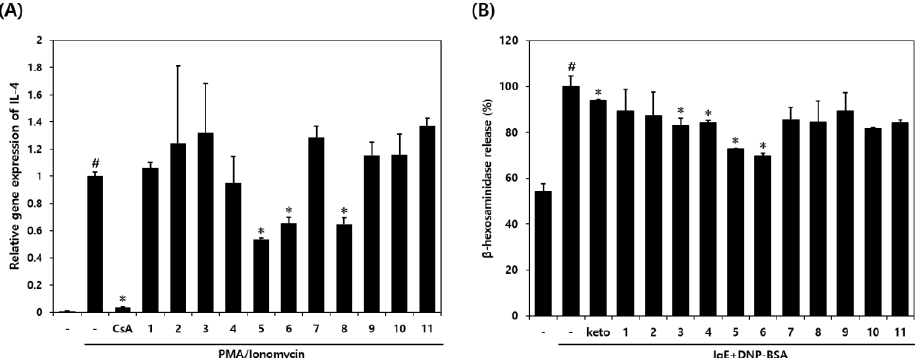
Figure 5. Anti-inflammatory and anti-allergic effects of compounds isolated from DCE on IL-4 levels and β -hexosaminidase release. ( A ) Expressions of IL-4. ( B ) β -hexosaminidase release. CsA: PI plus cyclosporin A-treated group, keto: IgE + DNP-BSA plus ketotifen-treated group. Data values are presented as the means ± SDs. # p < 0.05 vs. vehicle controls, * p < 0.05 vs. the PI or IgE + DNP-BSA-stimulated cells.